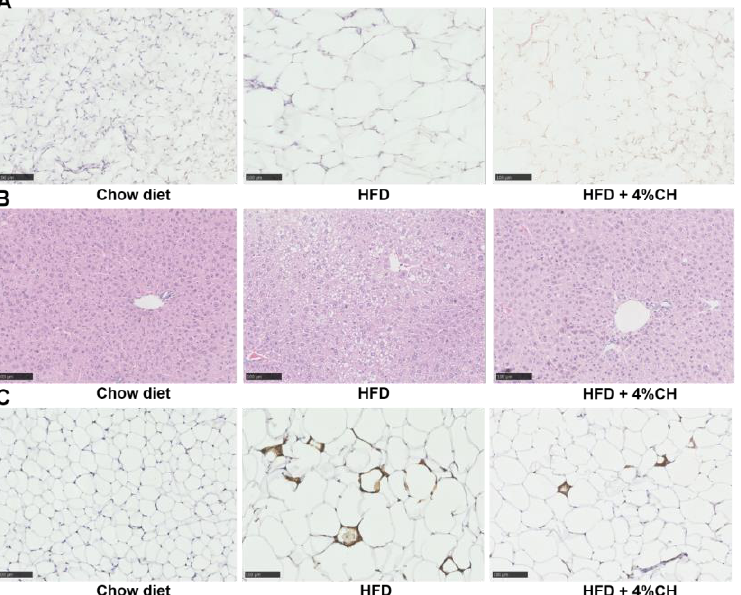
Figure 6. The effects of CH consumption on the histological change of epididymal adipose and liver tissue. Representative sections of epididymal white adipose tissue ( A ) and liver ( B ) stained with HE. Representative adipose tissue sections immunostained with F4/80 primary antibody ( C ). All images were presented at 100× magnification.